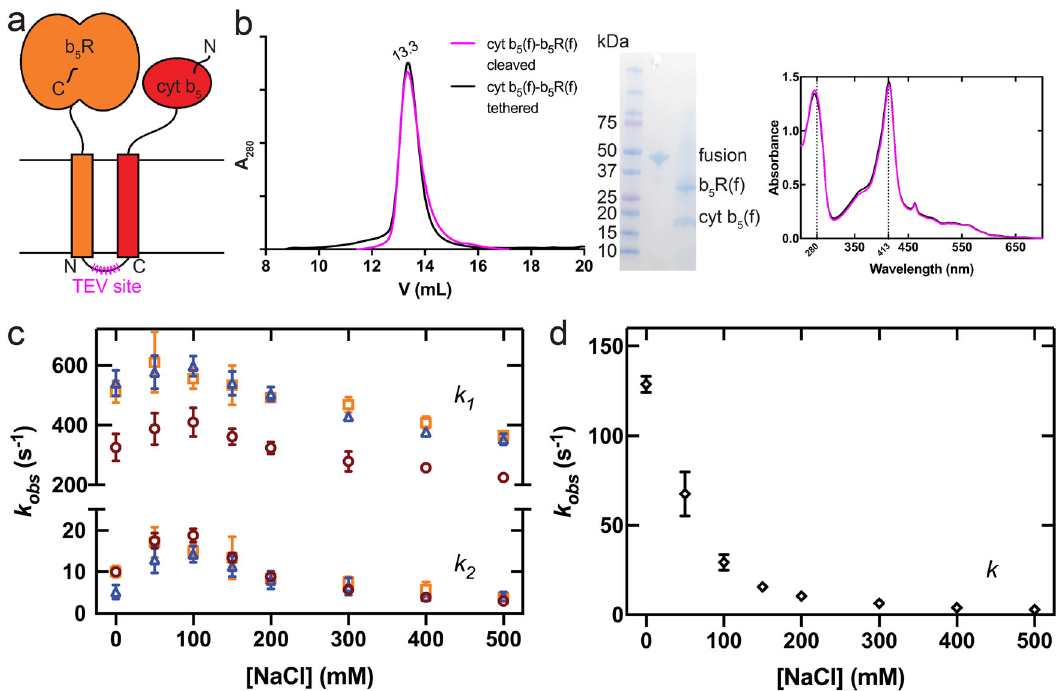
Fig. 3 Full-length cyt b5 and full-length b5R can form a stable complex with faster electron transfer kinetics. a Schematic diagram of cyt b 5 -b 5 R fusion constructs. The N and C denote the N-terminus and C-terminus of cyt b 5 and b 5 R. The magenta zigzag line indicates the placement of a TEV protease site on the linker region connecting the cyt b 5 and b 5 R. b Size-exclusion chromatography (SEC) pro fi le (left), SDS-PAGEl image (inset), and UV-Vis spectra (right) of the linker-cleaved (magenta) and tethered (black) fusion of SCD1-cyt b 5 . Almost identical SEC pro fi les and optical spectra suggest the stable assembly between cyt b 5 and b 5 R. c Ionic strength-dependent electron transfer in different constructs of cyt b 5 – b 5 R: linker-cleaved full-length (orange); tethered full-length (blue); tethered soluble without TM domains (red). The upper and lower half of the plot represent the rate constants of the fast phase ( k 1 ) and the slow phase ( k 2 ), respectively. d Ionic strength-dependent electron-transfer between individual b 5 R and cyt b 5 . Different from those of cyt b 5 - b 5 R fusions, the time courses with individual b 5 R and cyt b 5 are monophasic. Error bars represent standard error of the mean (SEM) from three independent repeats ( n =